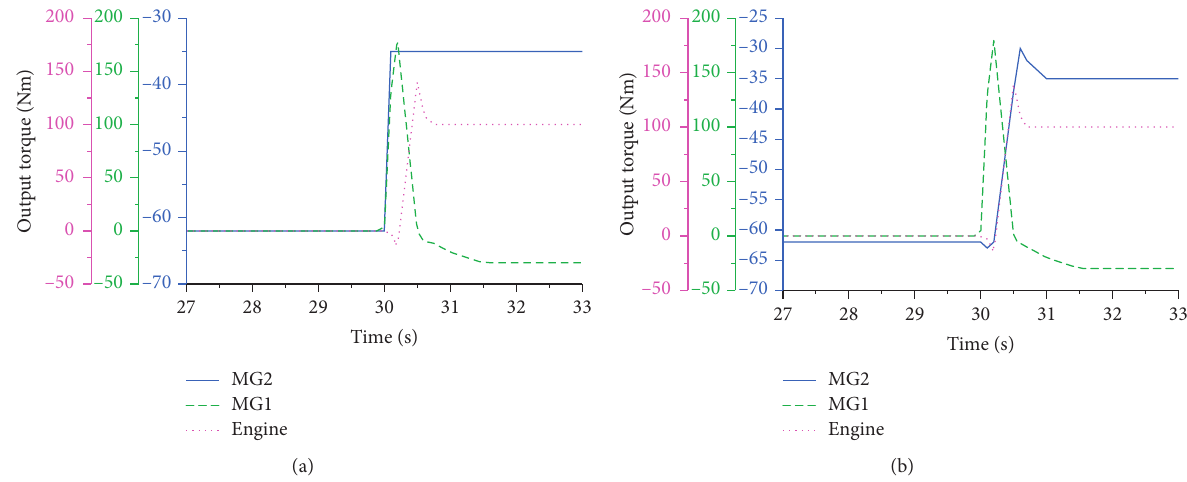
Figure 11: Output torque of power sources. (a) Output torque of each power source before control. (b) Output torque of each power source after control.